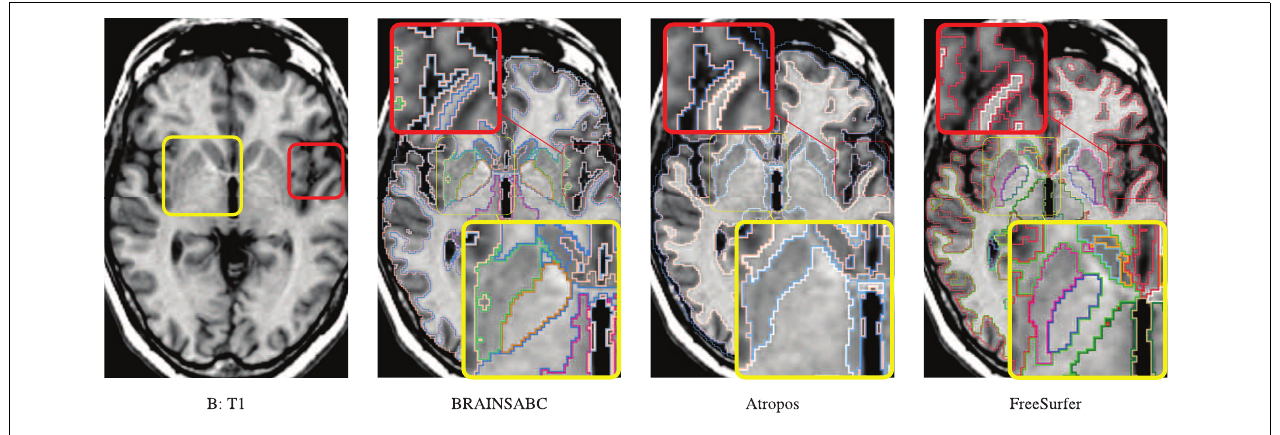
FIGURE 5 | Visual Comparison of Scan B in Table 2. Tissue classification results from three applications, BRAINSABC, Atropos of ANTS Tools, and FreeSurfer on top of T1-weighted images, uni-modal processing. This subject present relatively small tissue ratio, reflecting brain atrophy progression to some extent. Again,